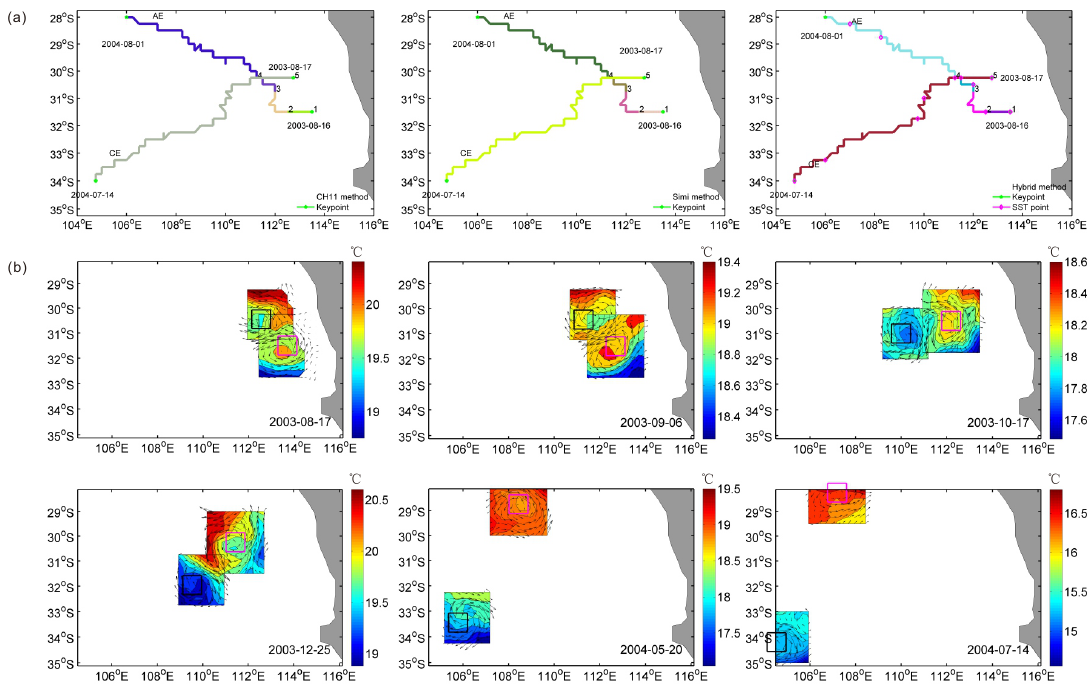
Figure 7. Two eddies tracked in the eastern South Pacific Ocean from August 2003, to August 2004. ( a ) Tracking paths from the three methods; ( b ) Corresponding SST and geostrophic current field along the trajectory of the hybrid